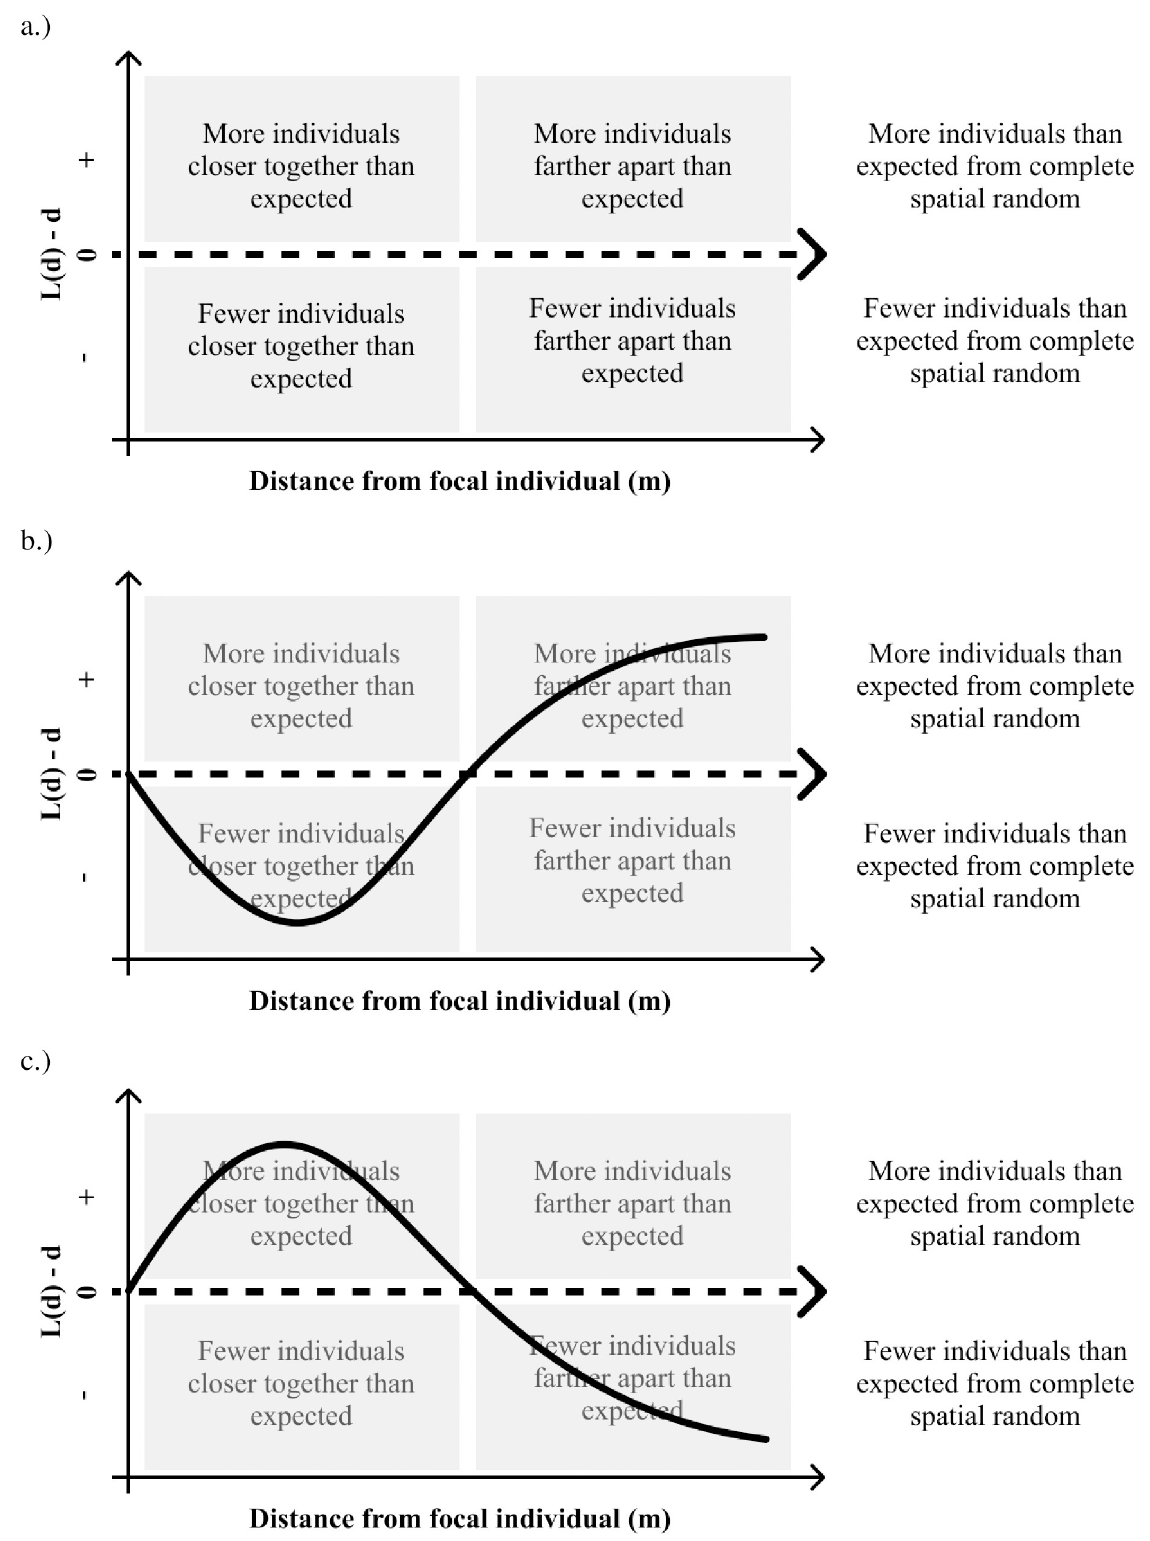
Fig 1. Conceptual representation of L(d)-d and representative spatial patterns. a.) Conceptual diagram of interpretations of different quadrants of spatial point pattern space for Besag’s L after it has been centered by distance. b.) Hypothetical distribution where